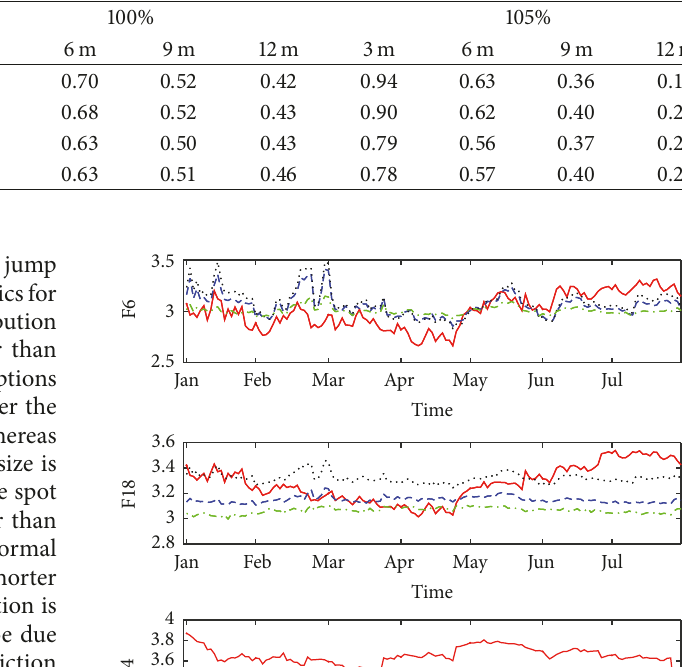
Table 2: Ratios between the JDMN and JDMExp option prices.